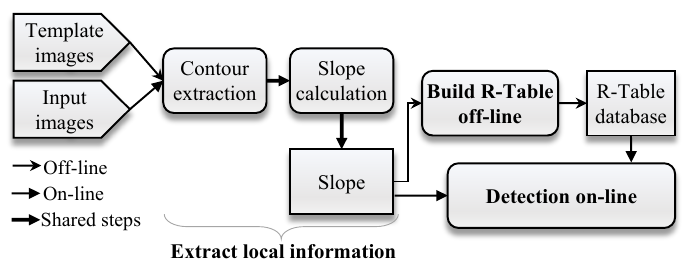
Figure 2. The overall diagram of the